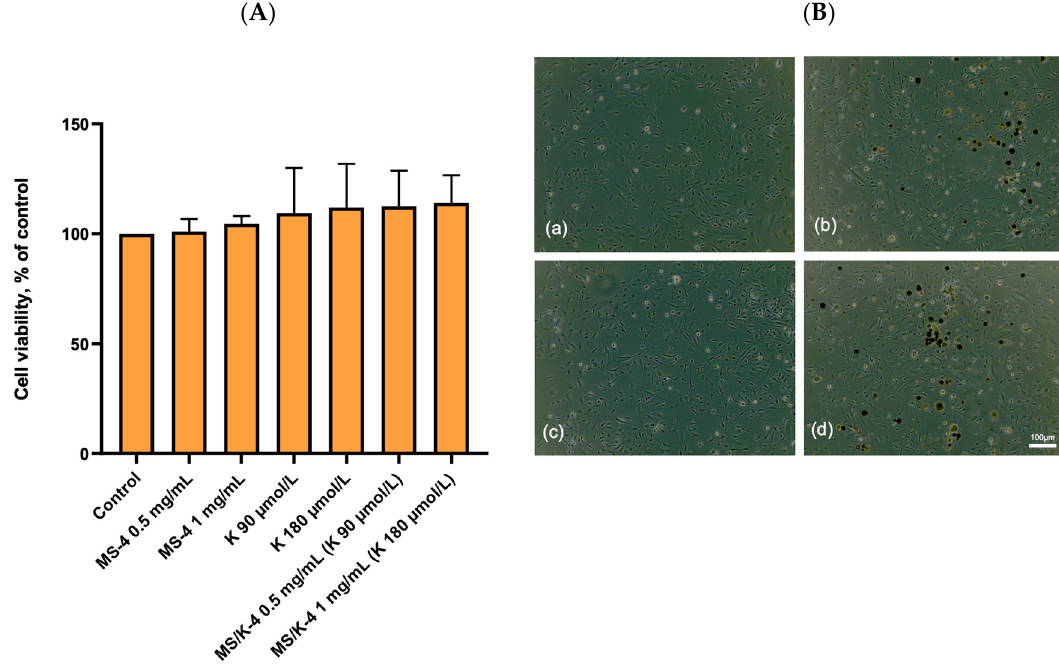
Figure 8. Effects of MS/K-4 on cell viability. HMEC at confluence was treated with MS/K-4, LYS, or MS-4 for 24 h at the concentrations indicated. ( A ) Cell viability was assessed via an MTT assay and was expressed as the percent of the basal (untreated) control. Data (means ± S.D.; n = 3) were expressed as a percent of the untreated control. ( B ) Images of the cell monolayer visualized and acquired with a phase-contrast microscope at 10× magnification: ( a ) control; ( b ) MS-4 1 mg/mL; ( c ) LYS 180 µmol/L; ( d ) MS/K-4 1 mg/mL.